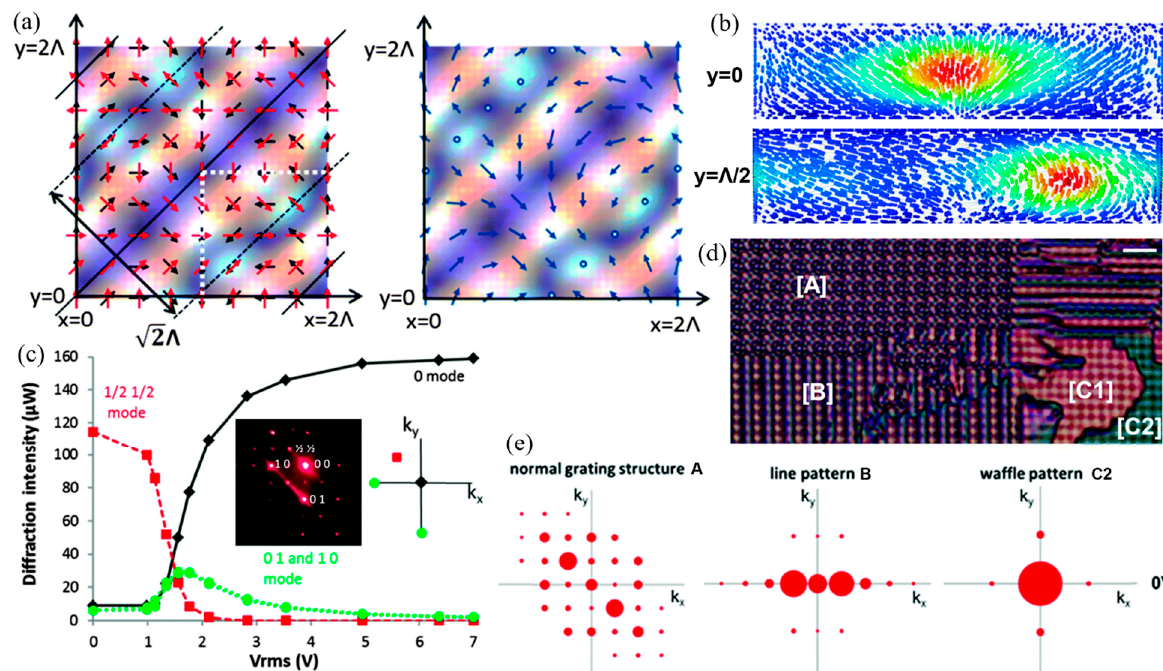
Figure 4. ( a ) LC texture observed by POM with LC director distribution illustrated for the top substrate (red on the left), bottom substrate (black on the left) and mid-plane (blue on the right) of a cell. ( b ) Simulated director profile of the cross-section for y = 0 (top) and y = Λ /2 (bottom) in the dimension of 2 Λ *2 Λ *d. ( c ) Measured diffraction intensity as a function of the ac voltage with RCP incident light. Inset: Diffraction pattern with 2-V applied voltage. ( d ) POM image of a 2D LC PG with different surface anchoring conditions with a half Λ /d ratio compared to the sample of ( a – c ): (A) strong anchoring on both substrates, (B) strong and weak anchoring on the bottom and top substrates, respectively, and (C) weak anchoring on both substrates. ( e ) Simulated diffraction pattern with unpolarized incident light for regions A, B and C2 of the sample ( d ). Reproduced from References [34,35] with permission from the Royal Society of Chemistry.